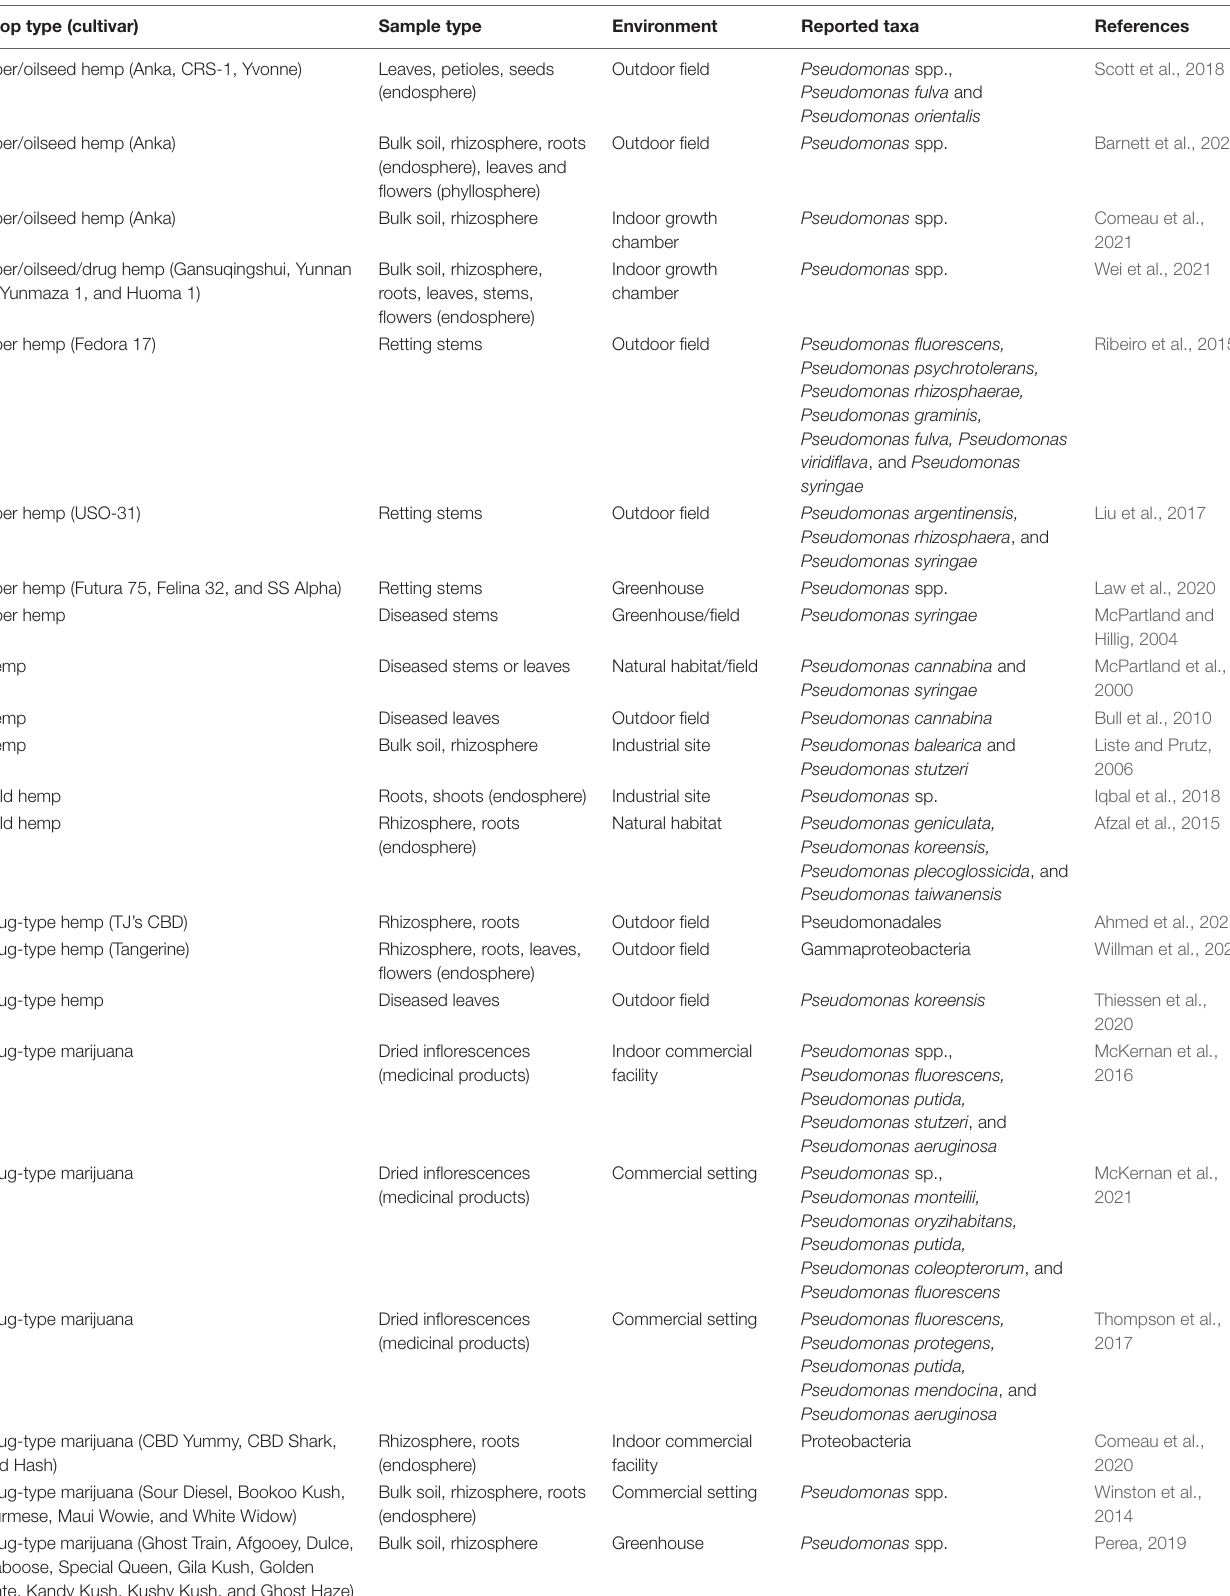
TABLE 1 | Pseudomonas spp. (or higher related taxa) associated with the cannabis